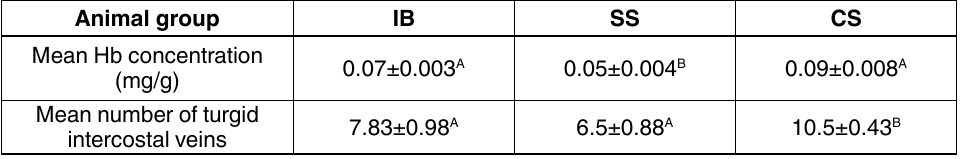
Table 3. Mean haemoglobin (Hb) content (mg/g) of imperfectly bled (IB), scientifically slaughtered (SS) and cold slaughtered (CS) carcasses and the various primal cuts (Mean±S.E.)